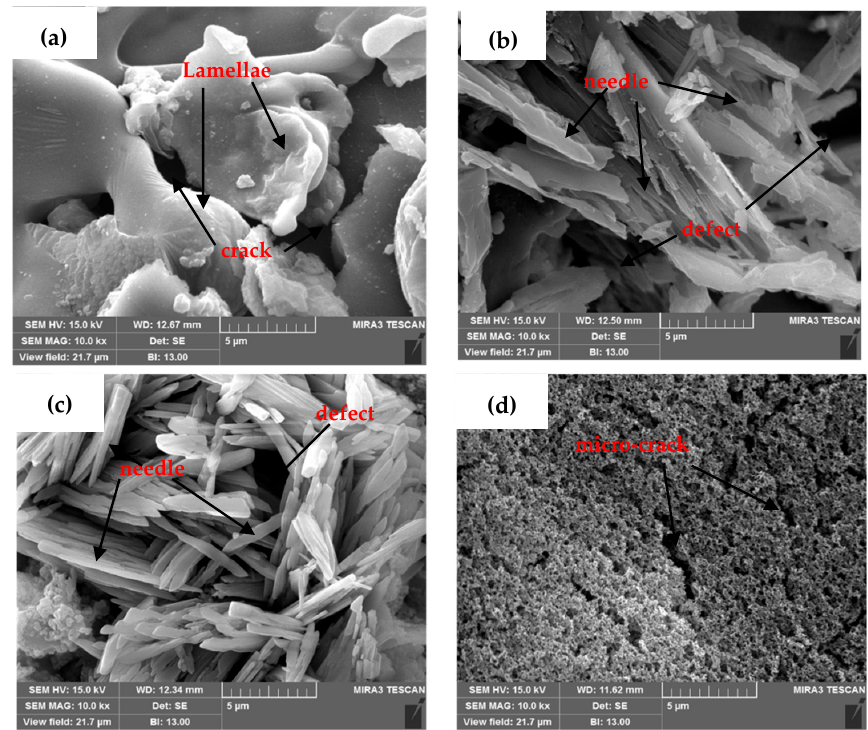
Figure 1. SEM of ( a ) as coated (AC), ( b ) 0.1 M NaH 2 PO 4 + 0.1 M Ca(NO 3 ) 2 (SPCN1), ( c ) 0.5 M NaH 2 PO 4 + 0.1 M Ca(NO 3 ) 2 (SPCN2), and ( d ) 1 M NaH 2 PO 4 + 0.1 M Ca(NO 3 ) 2 (SPCN3).